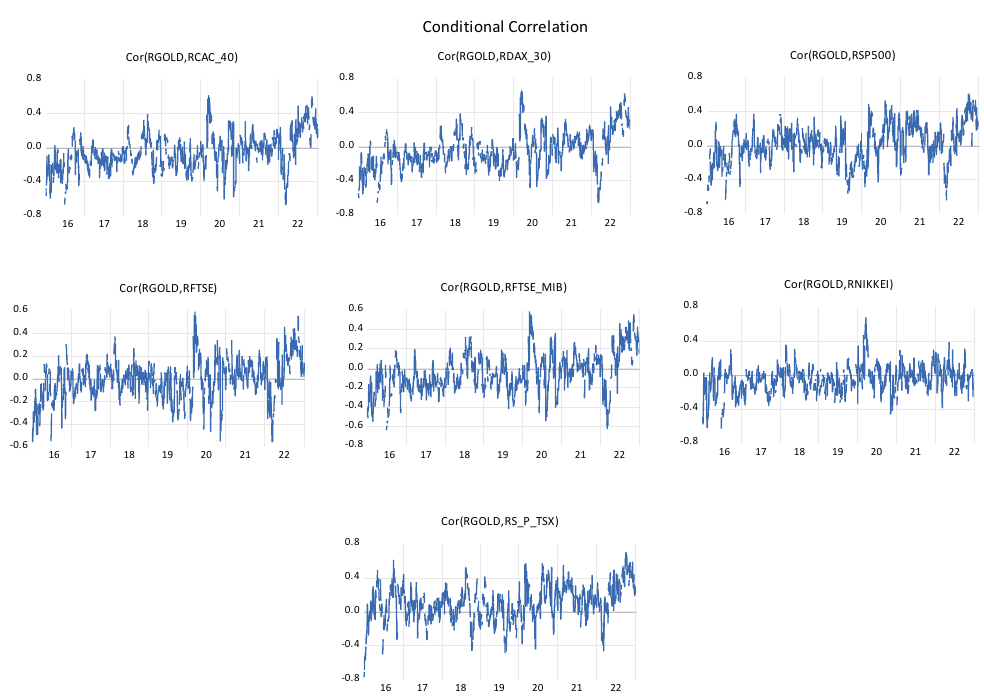
Figure A2. Dynamic conditional correlation evolution between Gold and each of the G7 stock market indices.